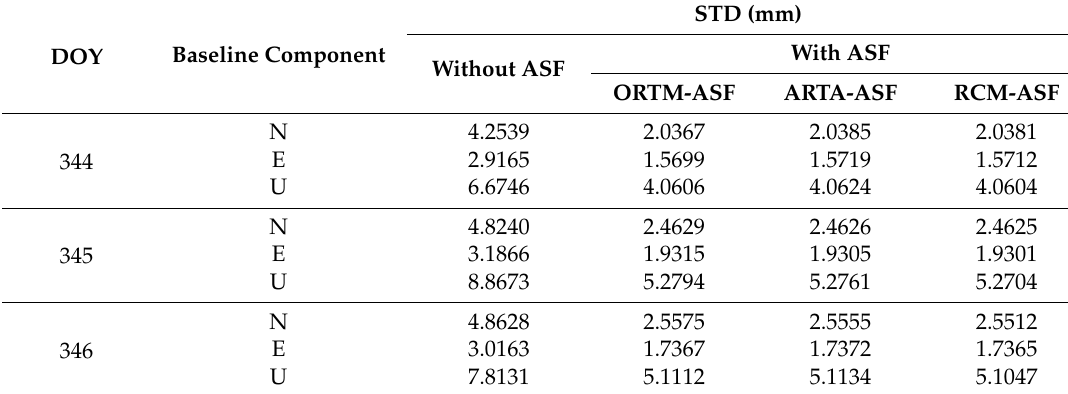
Table 1. STD of time series of baseline components estimated from observables with and without ASF correction (Excluding PRN